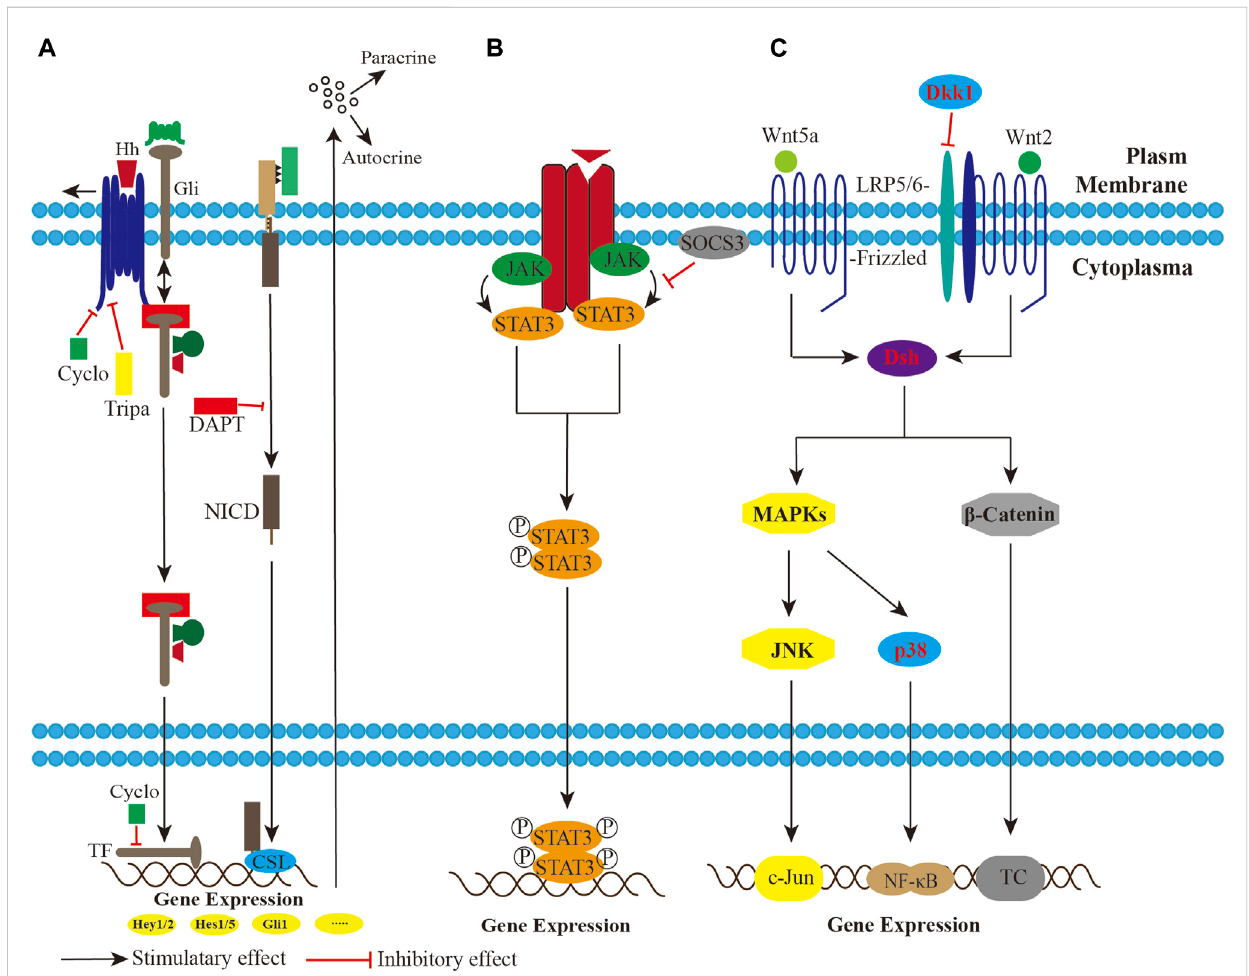
FIGURE 3 A schematic imaging showing the potential involvement of pathways in the UPS/MFS. (A) . The Hedgehog (Hh) and Notch signaling modulation are activated, and impose paracrine and autocrine effects on the sarcoma cells, maintaining mesenchymal stromal or stem cells in a less differentiated state. Pharmocological blockade by triparanol, cyclopamine and DAPT successfully inhibits Hh or Notch signaling. (B) . Phosphorylated STAT3 dimer functions as transcriptional complex (TC) in the Janus kinase (JAK)-signal transducer and activator of transcription (STAT) pathway. Suppressor of cytokine signaling 3 (SOCS3) overexpression has an effect on STAT3 dephosphorylation. (C) . Both Wnt2/ β -catenin and Wnt5a/JNK non-canonical signaling inactivation inhibit developmental program in UPS/MFS. Wnt5a/JNK non-canonical signaling might be the upstream regulator of NF- κ B